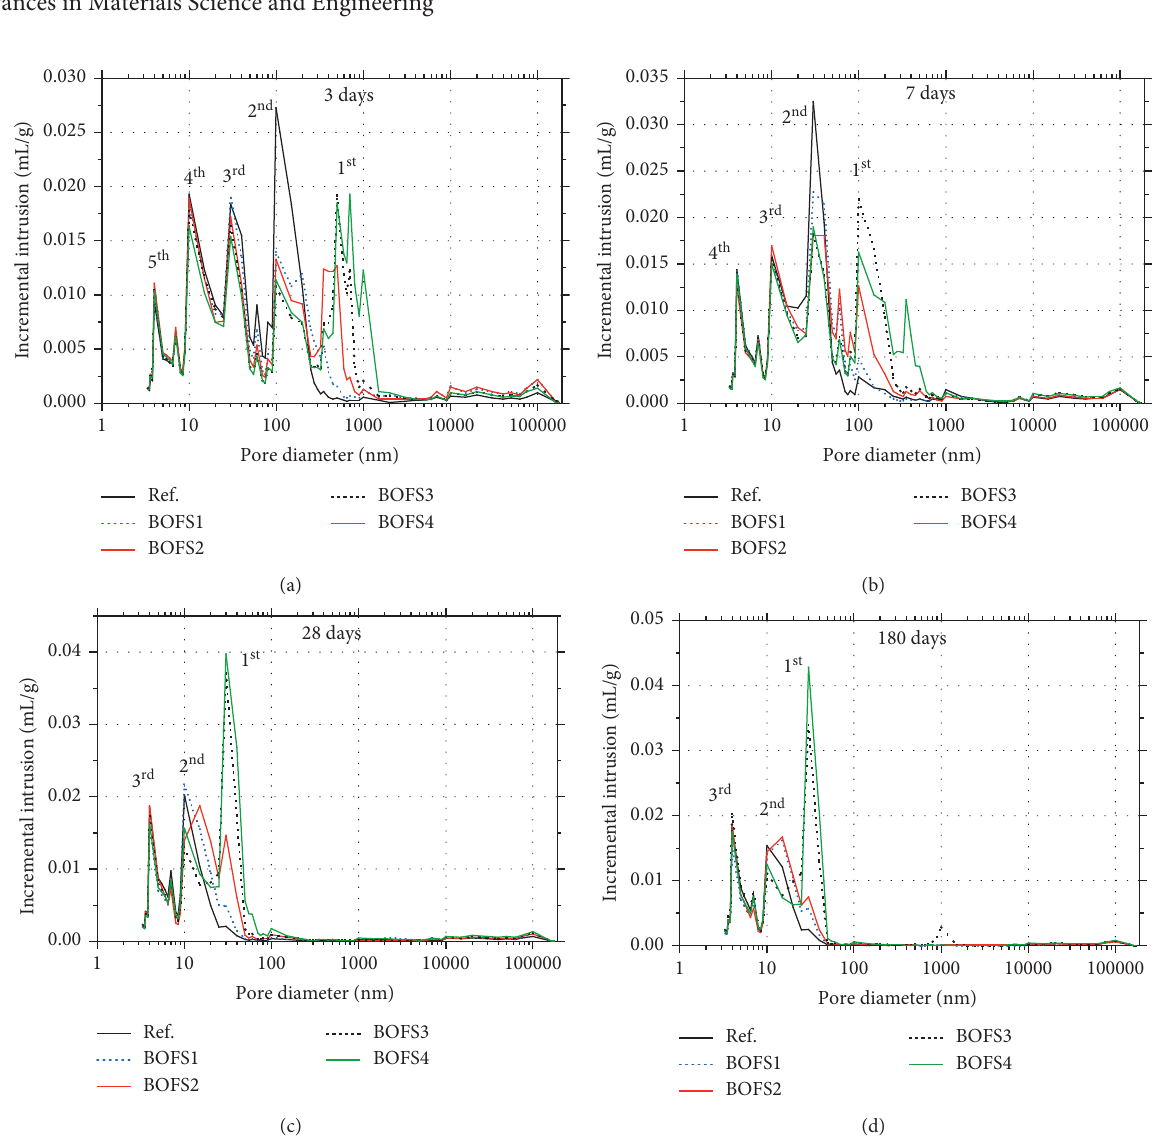
Figure 3: Incremental PSD curves of cement pastes with BOFS at different curing